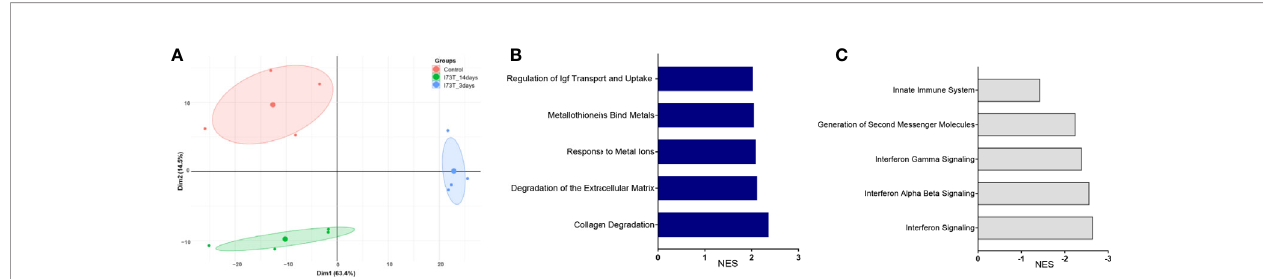
FIGURE 2 | RNA sequencing analysis of fl ow cytometry sorted cells shows temporal dynamics in CD11b + Ly6C hi monocytes function following SP-C I73T induced injury. RNA-sequencing of cell sorted CD11b + Ly6C hi monocytes from control (CTL, oil treated SP-C I73T mice) or SP-C I73T mice 3 d and 14 d after injury. Total RNA was prepared and analyzed by RNA-seq. N = 4 was utilized in each study condition. (A) , Two-dimension principle component analysis (PCA) of gene expression variance among monocytes accumulating in the lung in control (CTL) or SP-C I73T mice 3 d and 14 d after injury. (B) Positively enriched pathways at 3 d post injury (normalized enrichment score, NES); (C) Negatively enriched pathways at 14 d post